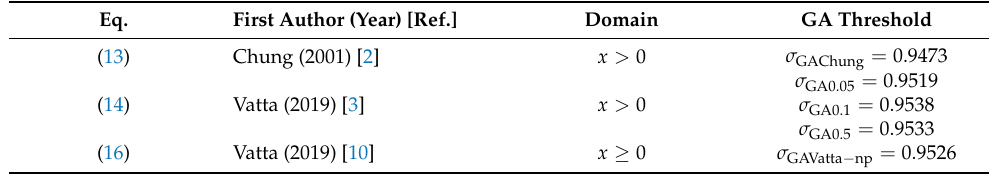
Table 2. GA thresholds calculated by applying different approximations of the function φ ( x ) and of its